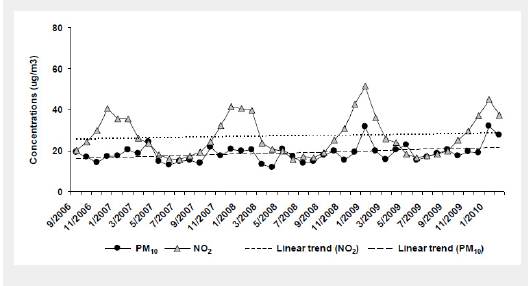
Average monthly outdoor concentrations of PM 10 and NO 2 in Graubünden from September 2006 to February 2010. The dashed lines show the overall trends in the concentrations of the respective parameter over time.